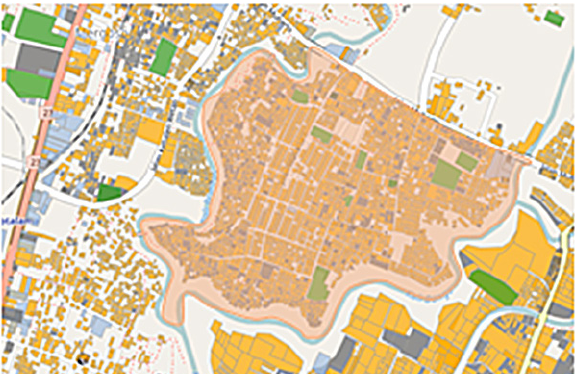
Figure 1. The area of Malang Kotalama settlement (source: Asikin et al., 2017)